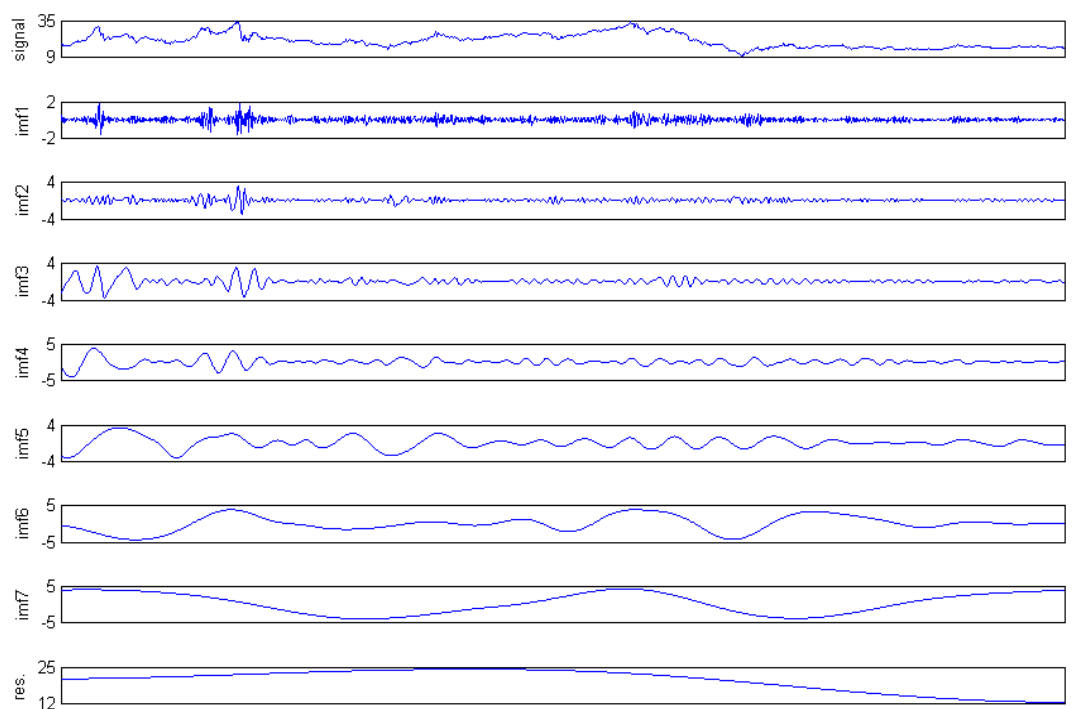
Figure 5. The decomposition of DEC12 derived from